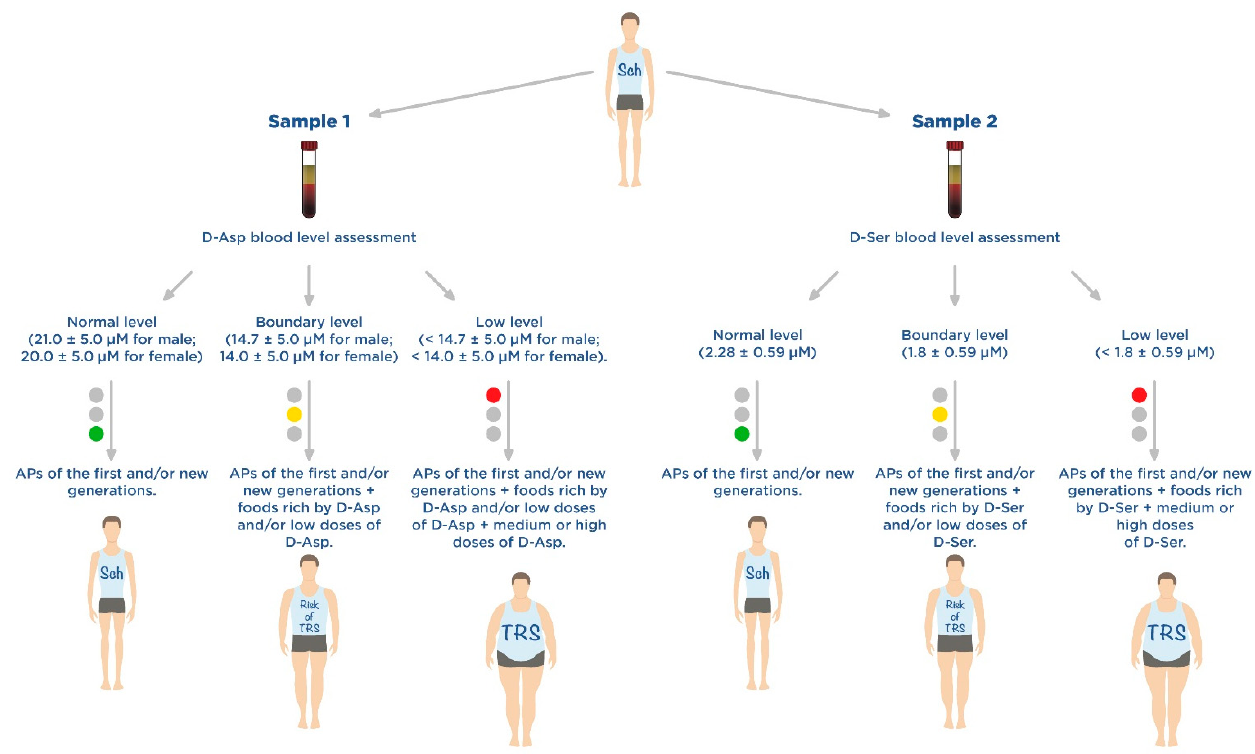
Figure 7. Personalized nutritional support algorithm for patients with schizophrenia (Sch) and treatment-resistant schizophrenia (TRS): the choice of diet and/or disease-modifying therapy for Sch depends on the level of D-aspartate (D-Asp) and/or D-serine (D-Ser) in the blood and personal risk of developing TRS-associated with a deficiency of these D-amino acids; green—low risk of TRS; yellow—medium risk of TRS; red—high risk of